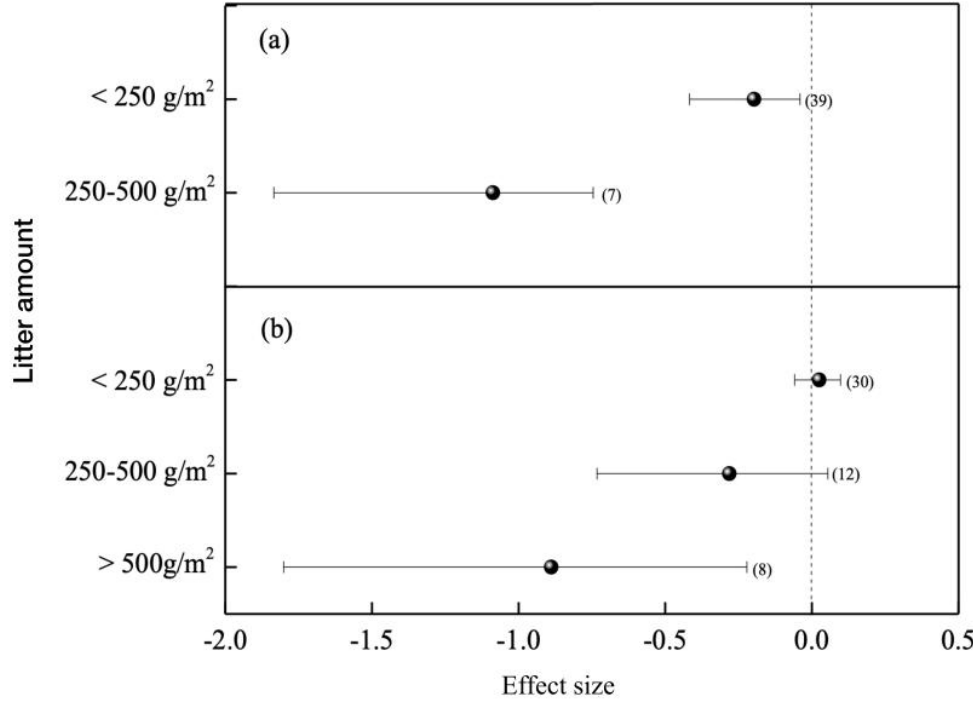
Figure 7. Mean effect size for emergence under different litter amounts of small ( a ) and large ( b ) seed sizes. Error bars represent 95% CIs.